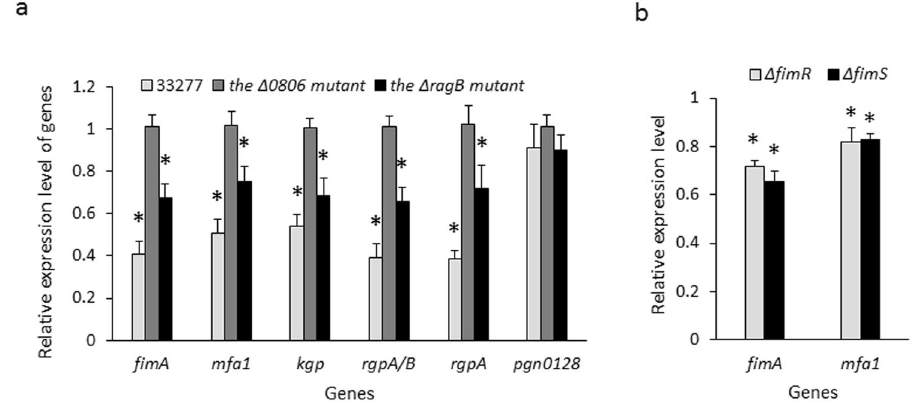
Figure 6. Comparison of virulence gene expression in P . gingivalis 33277 and its mutants. Expression of fimA , mfa1 , rgpA + B , rgpA , and kgp was determined using qRT-PCR. P . gingivalis strains was grown TSB in the presence or absence of peptide4 at a concentration 16 µ M. ( a ) The mRNA levels of genes in 33277, the pgn_0806 , and the ragB mutants grown in the media supplemented with peptide4 are indicated relative to the expression level in P . gingivalis 33277 grown in the medium without peptide4 (1 unit). ( b ) The fimR ( Δ fimR) and fimS ( Δ fimS) mutants were grown with or without the peptide4. Each bar represents relative expression level of fimA or mfa1 in the mutants grown with peptide4 (16 µ M) to those in the mutant grown in the media without peptide4 (1 unit). Results shown are means and standard deviations from three independent experiments. Asterisks indicate the statistical significance of expression levels of genes in P . gingivalis strains grown with/ without peptides ( P < 0.05; t